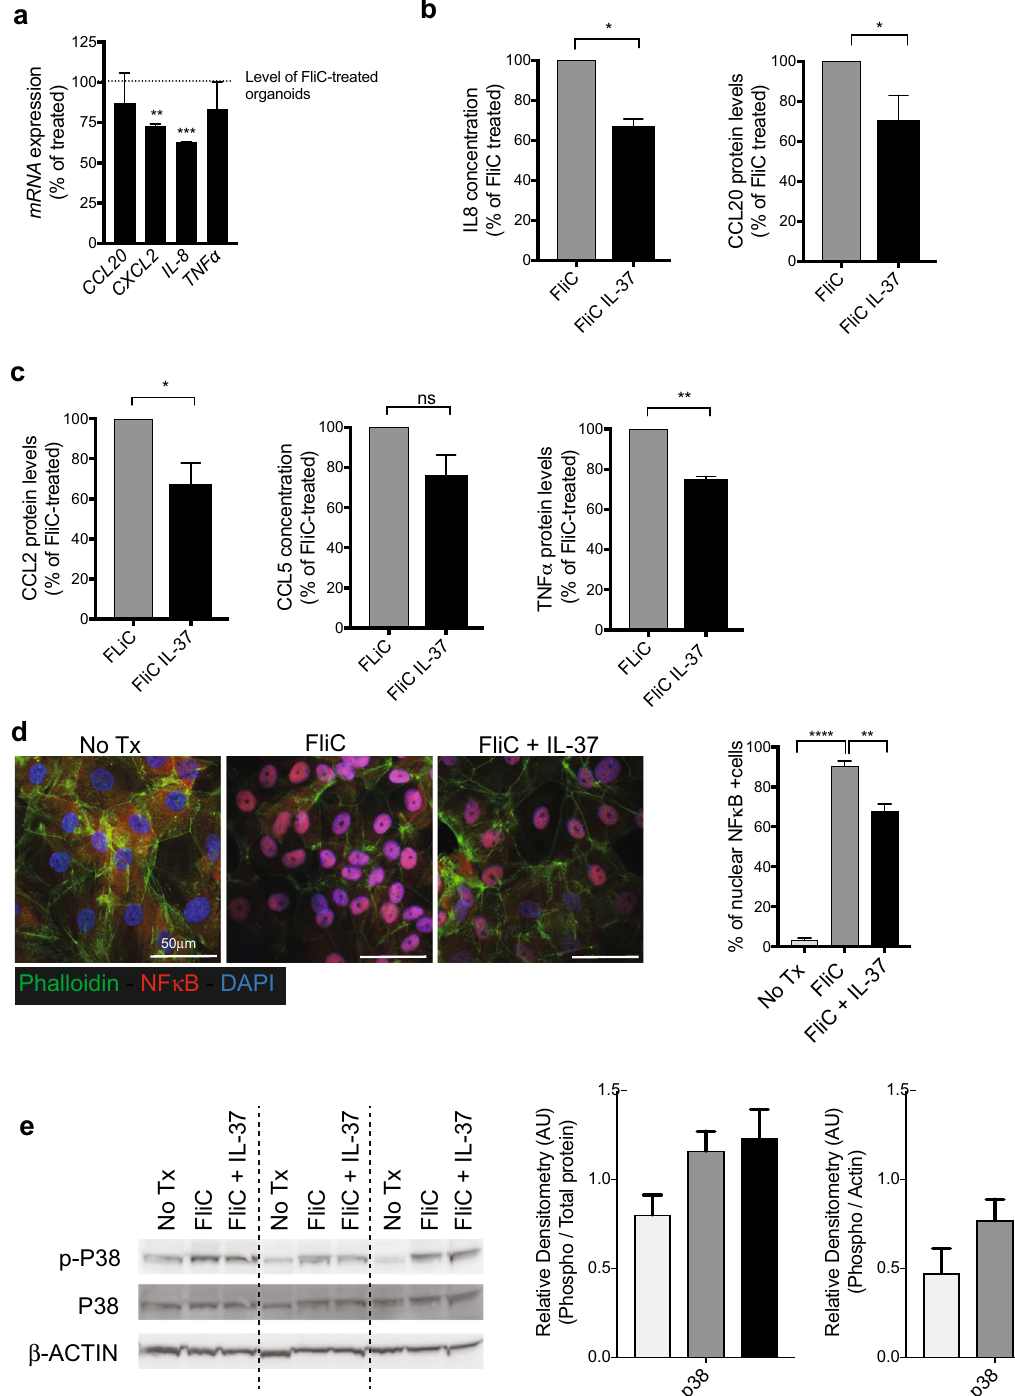
Figure 2. IL-37 effect on human IEC FliC responses. ( a ) qPCR analysis of inflammatory genes after FliC and IL-37 exposure for 4 h expressed as percentage of change over FliC treated colonoids. ( b ) IL-8 and CCL20 protein levels (detected by ELISA) secreted basolaterally by human colonoids after 4 h of stimulation with FliC and IL-37. ( c ) CCL2, CCL5 and TNFa protein levels secreted basolaterally by colonoids after 4 h of stimulation with FliC and IL-37 (detected by Milliplex Luminex assay). ( d ) Immunostaining against NFkB (red), actin (Phalloidin—green) and DAPI (blue) of 2D monolayer after 30 min of stimulation with FliC with or without IL-37 (left). Counts of NFkB positive nuclei from immunostaining (right). ( e ) Western blot analysis of phospho and total p38, after 30 min of stimulation with FliC with or without IL-37 (left). Equal loading confirmed with β-Actin as well as total protein stain of membrane (see Fig. S4 online). Densities relative to total protein or β-Actin are shown (right). Mean and SEM are indicated from n = 4 donors (2 adult and 2 pediatric). All data shown are representative of at least 3 independent experiments. Statistical significance calculated using unpaired Student’s t -test *, P = 0.01 to 0.05; **, P = 0.001 to 0.01; ***, P = 0.0001 to 0.001; ****, P = 0.00001 to 0.0001; ns = not